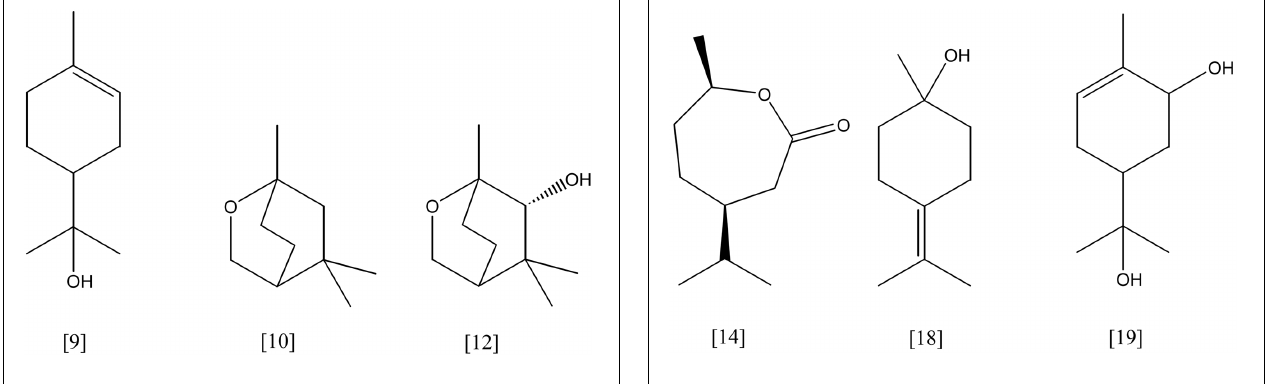
FIGURE 6 | isopropenyl-7-methyl-2-oxo-oxepanone [14]; γ -terpineol [18]; p -menth-1-ene-6,8-diol